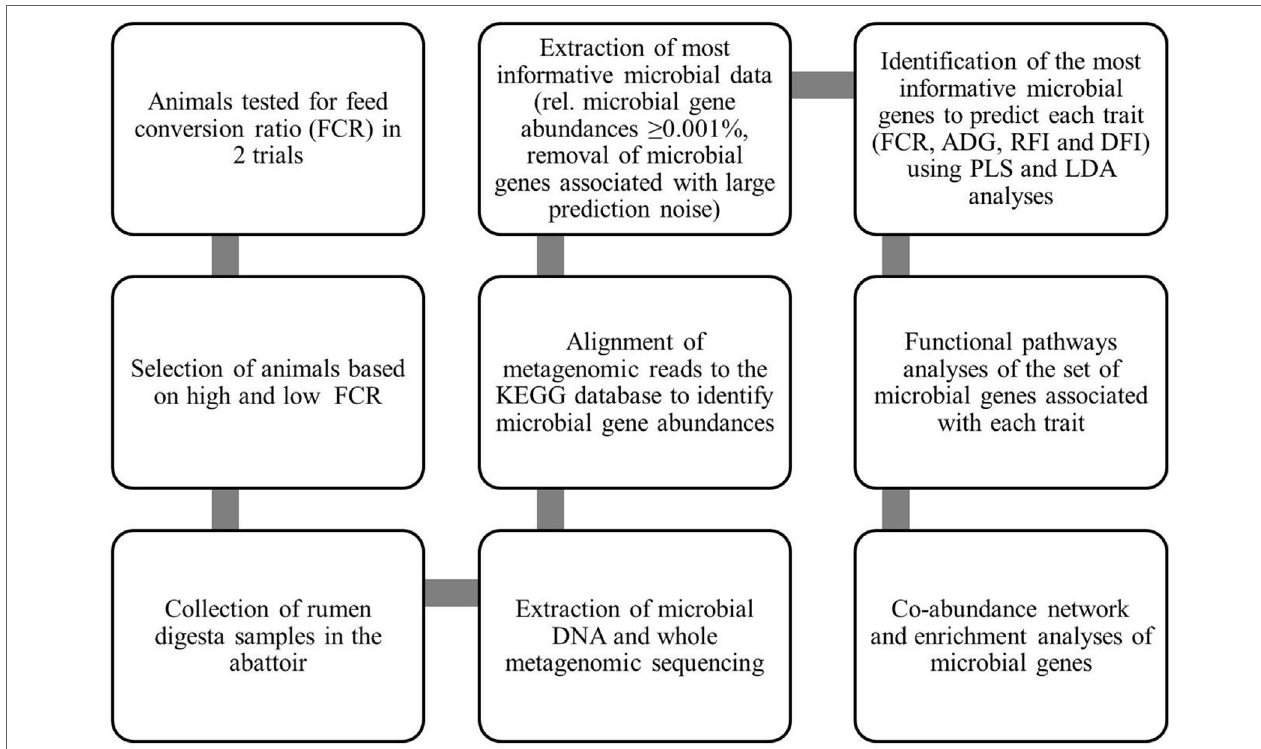
FIGURE 1 | Flowchart summarizing methods for generation of data and their statistical analyses: This flowchart summarizes how the data were generated and which statistical analyses were used to identify the associations between gene abundances and performance traits of animals to understand the rumen microbial functional pathways associated with these traits. KEGG, Kyoto Encyclopedia of Genes and Genomes; FCR, feed conversion ratio; ADG, average daily gain; RFI, residual feed intake; DFI, daily feed intake; PLS, partial least squares; LDA, linear discriminant